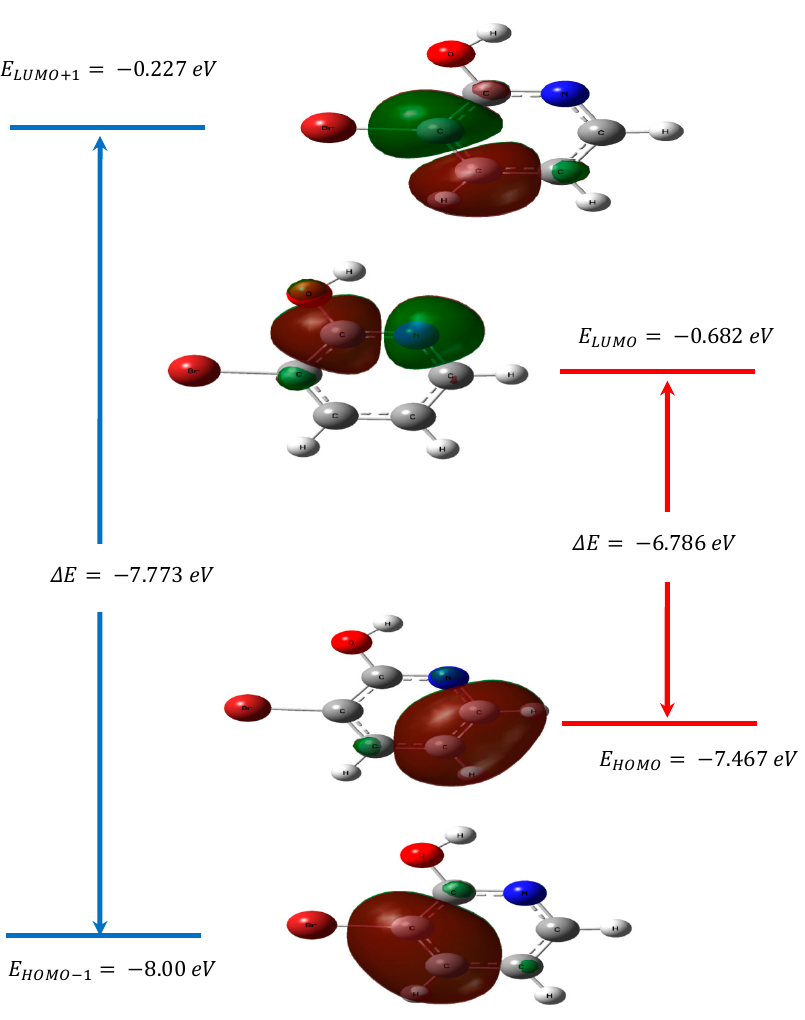
Figure 5. The first and second frontier molecular orbitals with the energy gap of 3-Br-2-HyP mole- cule.